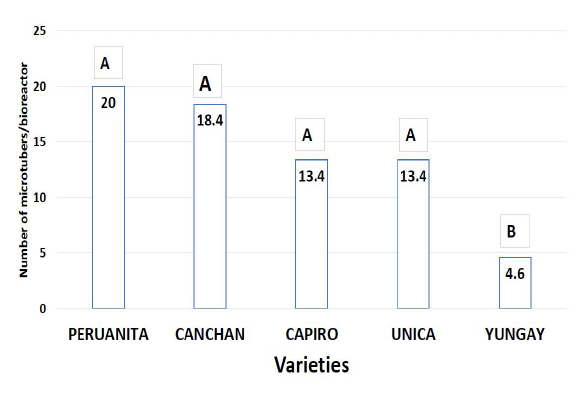
Figure 2. Comparison of microtuber yield means for each variety in the temporary immersion system (Tukey α =